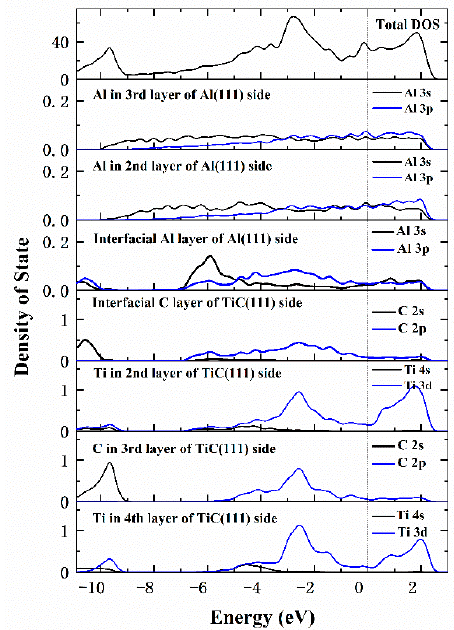
Figure 12. Total and partial density of states of interfacial atoms. The vertical dashed line indicates the Fermi level. Table 3. Lattice constants and electron work functions of Al and TiC.